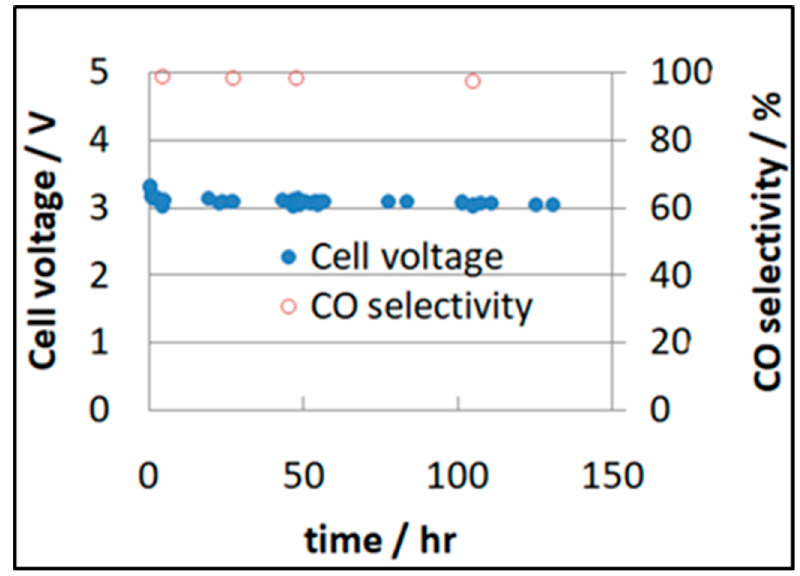
Figure 4. Cell voltage and CO selectivity of the 250 cm 2 CO 2 electrolyzer as a function of time, 200 mA/cm 2 and 35 °C. Humidified CO 2 was metered to the cathode at 1 L/min. The anolyte was a 20 mM KHCO 3 circulated through anode at a flowrate of 0.6 L/min.